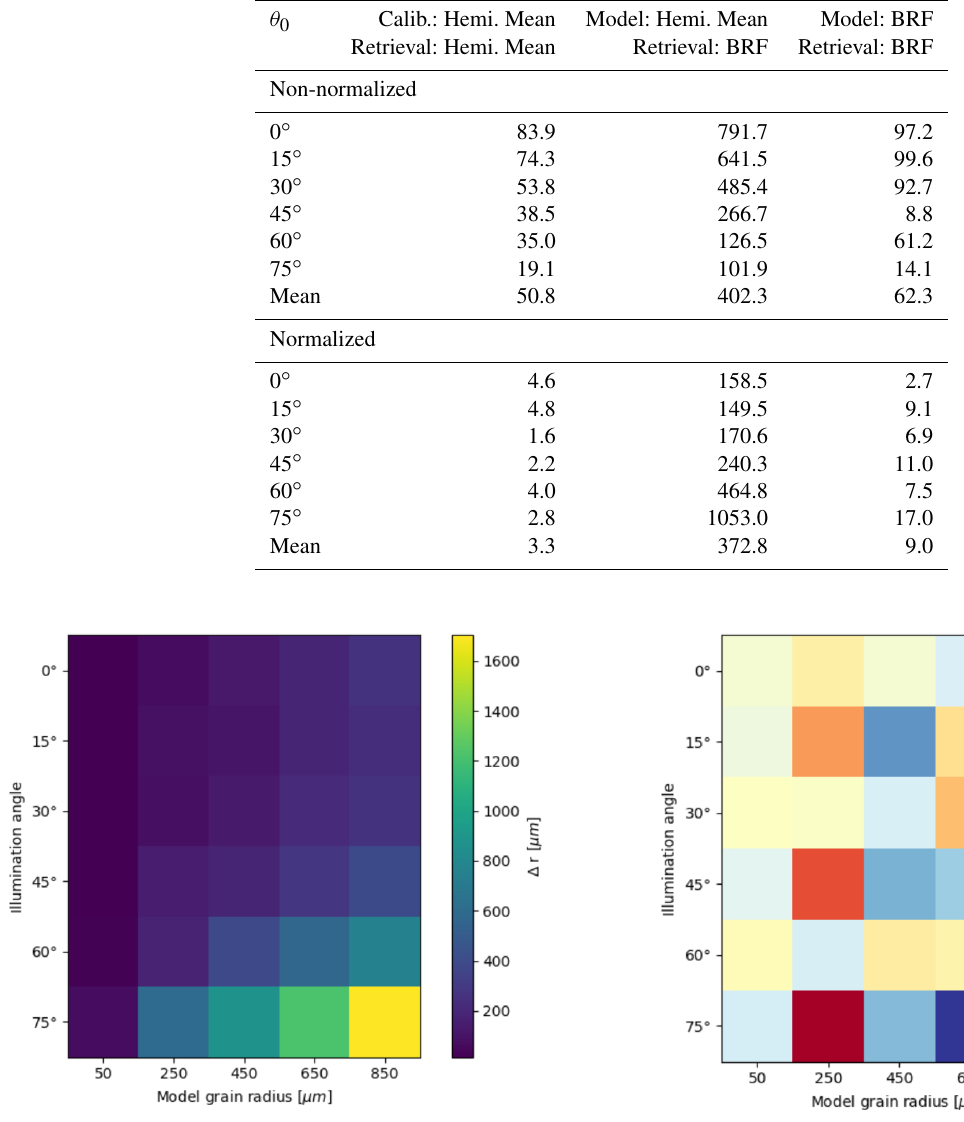
Figure 12. Retrieval errors as a function of model grain size and illumination angle, if using normalized band area. The errors as- sume that the inputs for the calibration curve and the retrieval are hemispheric reflectance and BRF, respectively.